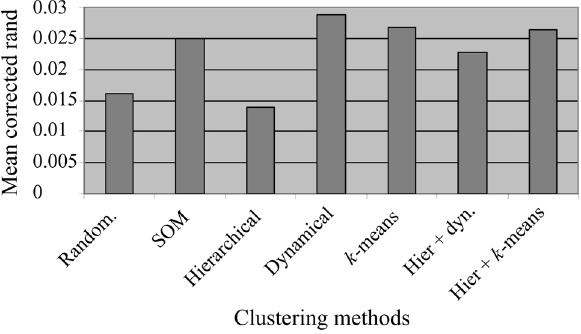
Figure 1 - Mean of corrected Rand values from the FC Yeast All experi- ments.